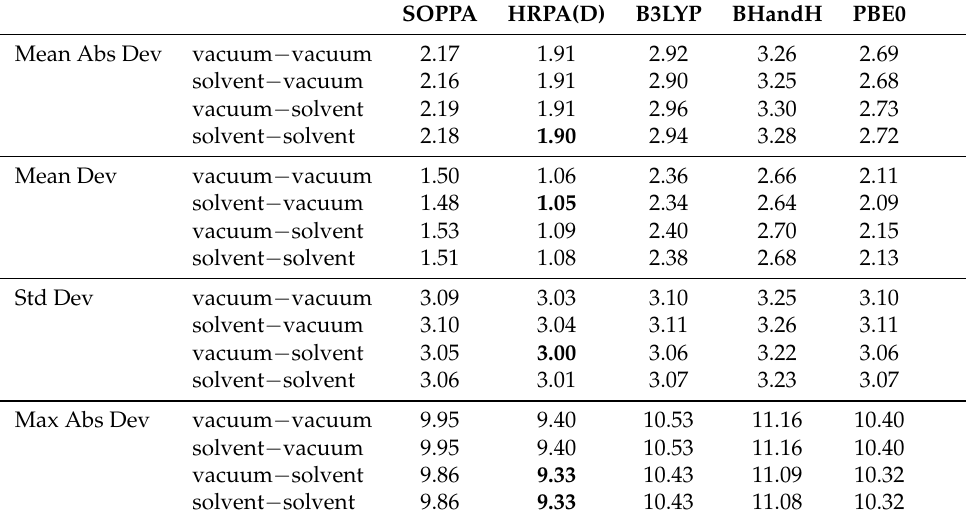
Figure 5. The statistics for all the 51 3 J HH coupling constants. Table 5. Statistical data for all the 3 J HH spin–spin coupling